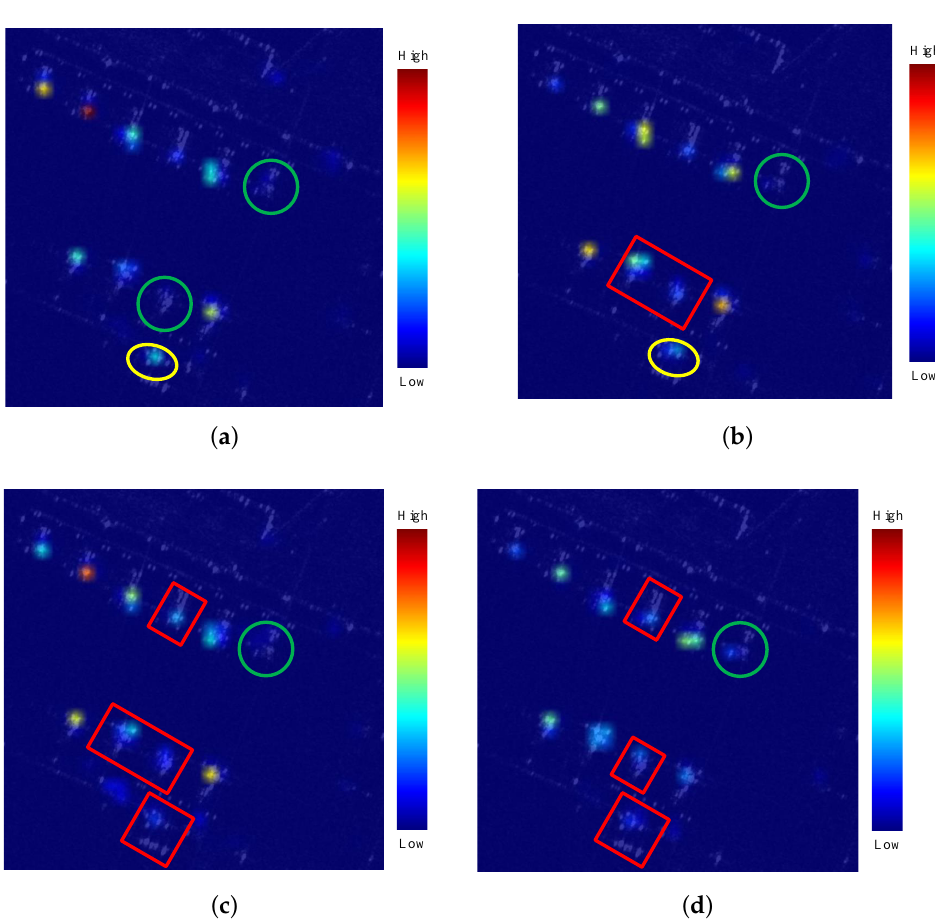
Figure 14. Visualization of grid probabilities. We label the accurately predicted targets, missing targets, and false alarms with red boxes, green circles, and yellow ellipses, respectively. ( a ) tiny. ( b ) +RB. ( c ) +ICB. ( d )